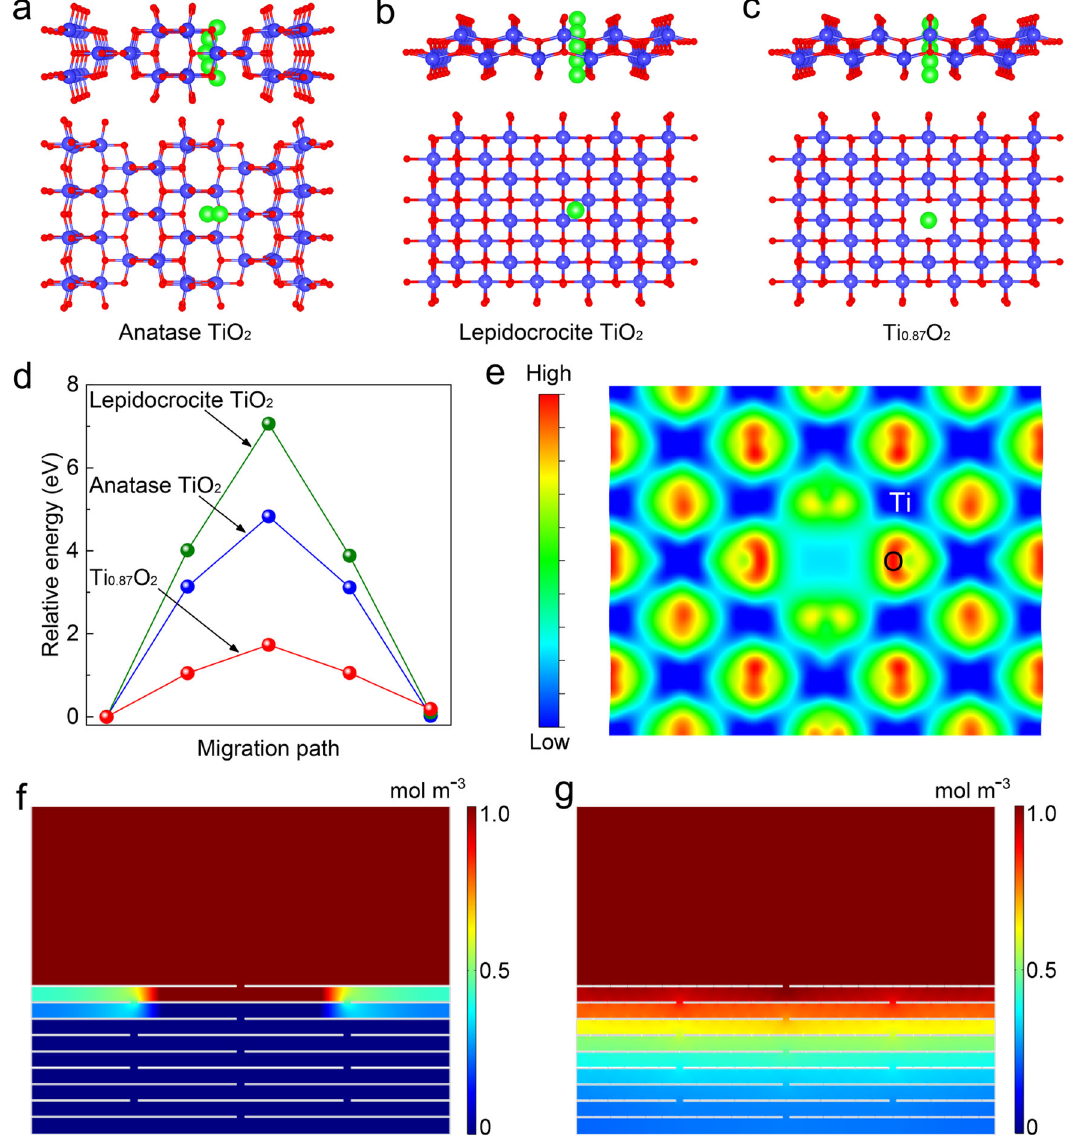
Fig. 4 Theoretical calculations and simulation results of ion transportation behaviors in Ti 0.87 O 2 nanosheets. Li + ion diffusion in ( a ) anatase TiO 2 , ( b ) lepidocrocite TiO 2 sheet, and ( c ) Ti-defective Ti 0.87 O 2 sheet. d Potential-energy curves of Li + ion diffusion in anatase TiO 2 , lepidocrocite TiO 2 , and Ti 0.87 O 2 . e Charge density plot of Ti 0.87 O 2 with a Ti defect. Distribution of Li + ions through a restacked thin layer of ( f ) conventional nanosheets and ( g ) Ti-defect